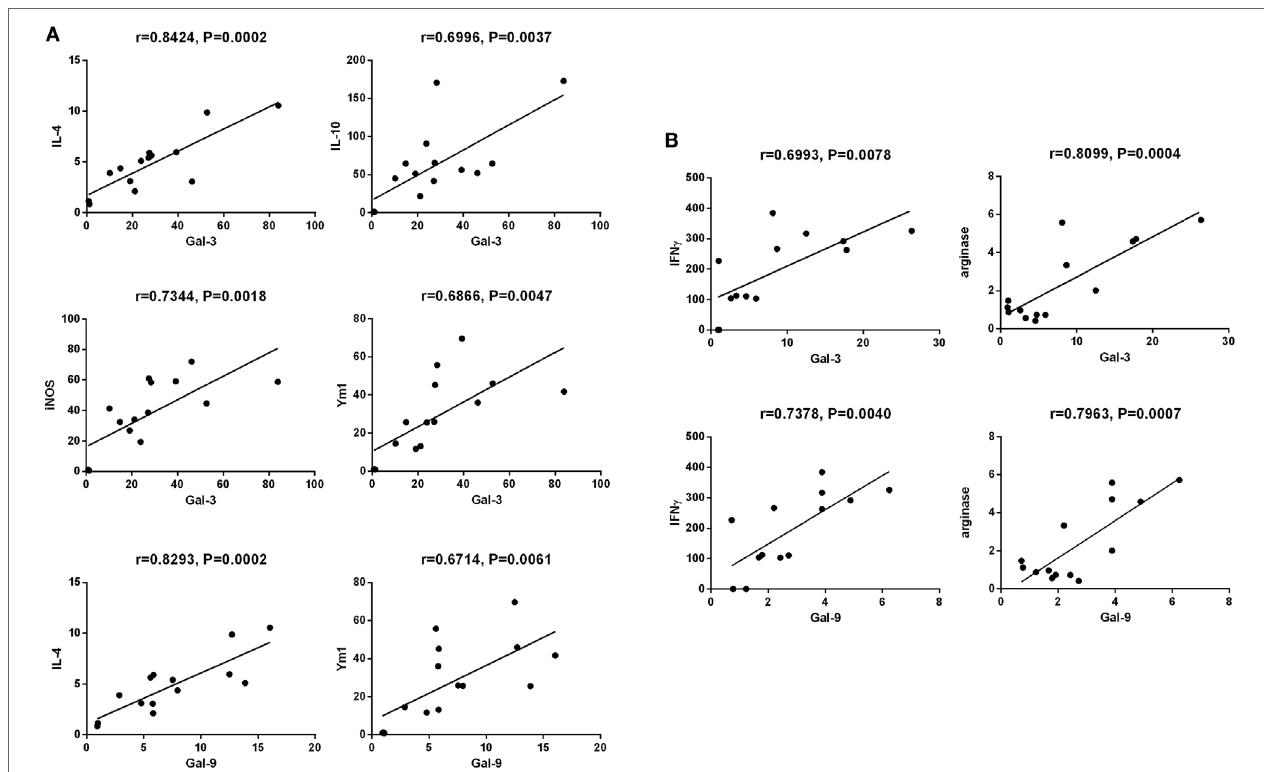
FigUre 7 | Correlation analysis between Gal-3 and T helper 1 (Th1)/Th2/M1/M2 cytokines as well as between Gal-9 and Th1/Th2/M2 cytokines in the brain tissues of Toxoplasma gondii Pru strain-infected C57BL/6 and BALB/c mice ( n = 16). (a) Significant correlations between Gal-3 and IL-4/IL-10/iNOS/Ym1 as well as between Gal-9 and IL-4/Ym1 existed in the brains of T. gondii -infected C57BL/6 mice. (B) Significant correlations between Gal-3 and IFN γ /Arg1 as well as between Gal-9 and IFN γ /Arg1 existed in the brains of T. gondii -infected BALB/c mice. The r value generates for the theoretical line of best fit, and the P value indicates the significance of the